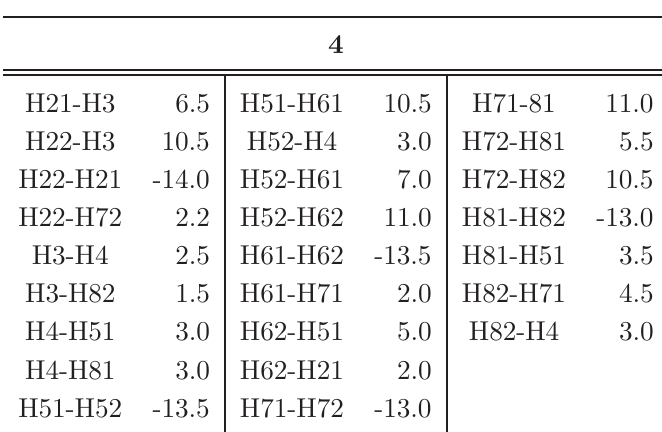
Table 3 Coupling constants ( J , Hz) deduced from the analysis of the 1 H NMR spectra of compound 4